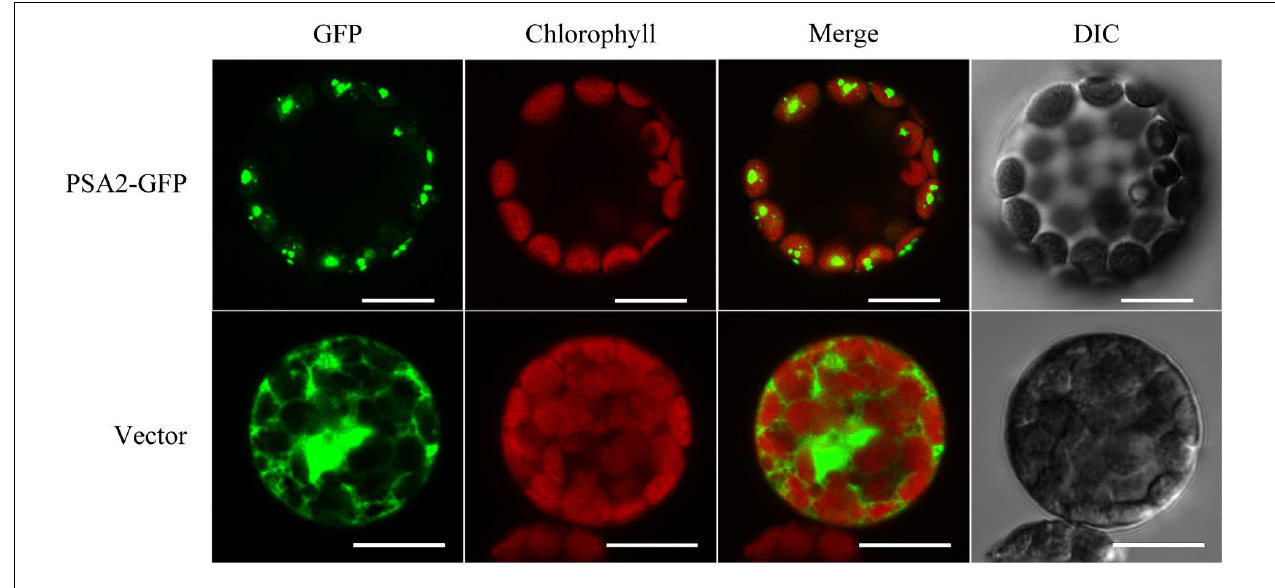
FIGURE 4 | Subcellular localization of PSA2 in chloroplasts. Protoplasts transformed with 35S:PSA2-GFP were observed under a FLUOVIEW FV1000 Laser Confocal Microscopy System (Olympus). Those transformed with pCAMBIA1302 empty vector were observed as a control. Bar = 20 µ m.